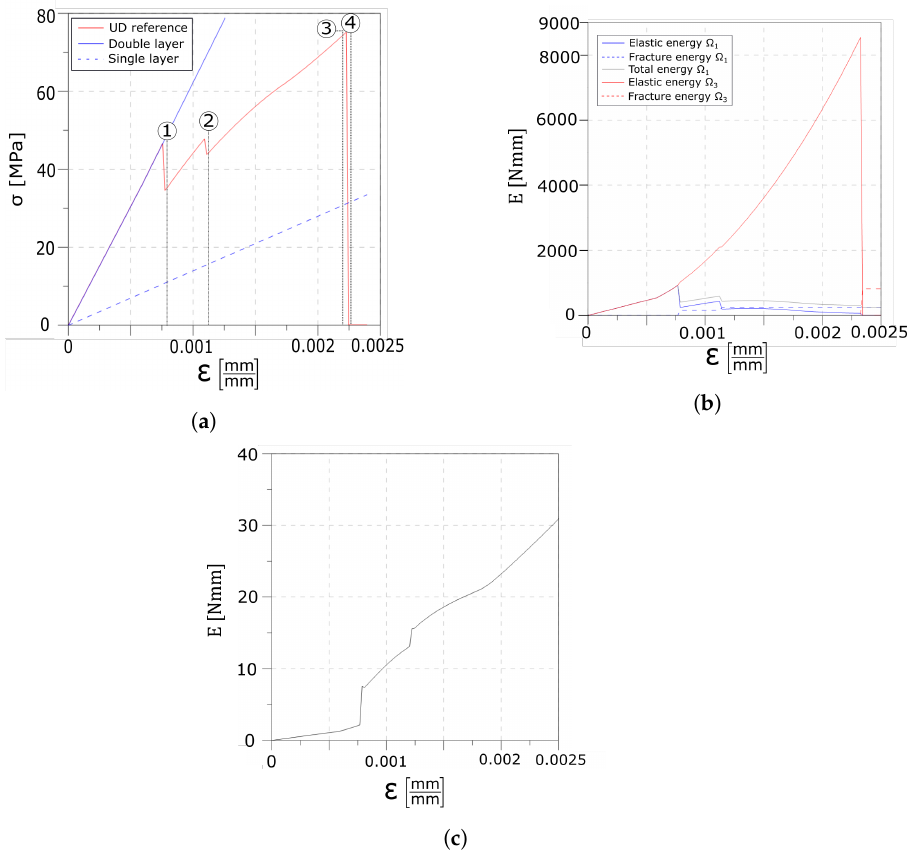
Figure 4. Numerical results of the unidirectional traction (UD) reference test: global response. ( a ) Global stress–strain response of the laminated glass beam. ( b ) Global evolution of the energy contributions. ( c ) Elastic energy contribution of the interlayer.